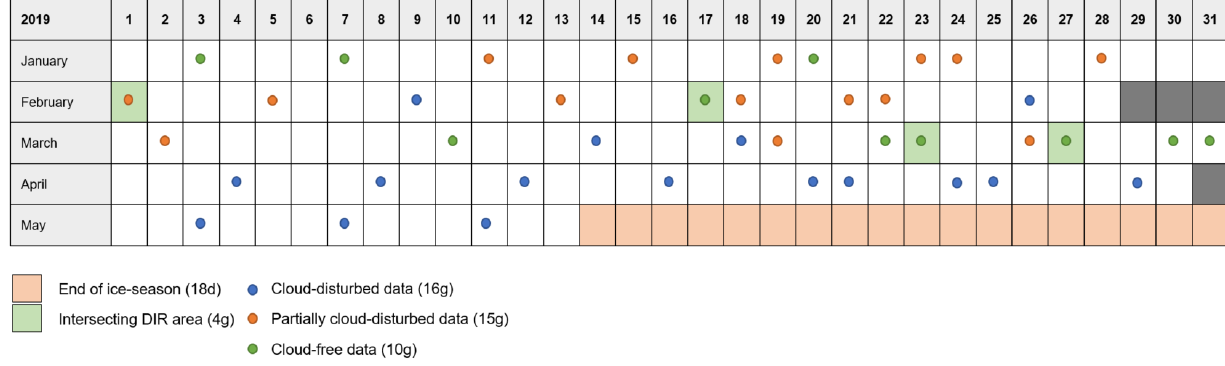
Figure 9. Availability of IS2 data granules (tracks) available during spring 2019 (January–May). Each dot represents an available granule which, by visual inspection, is categorised as cloud-disturbed data (blue), partially cloud-disturbed data (orange), or cloud-free data (green). Numbers in parentheses denote number of granules (g) or days (d). Coloured cells denote either end of the ice season (orange), intersecting DIR area (green), or not applicable